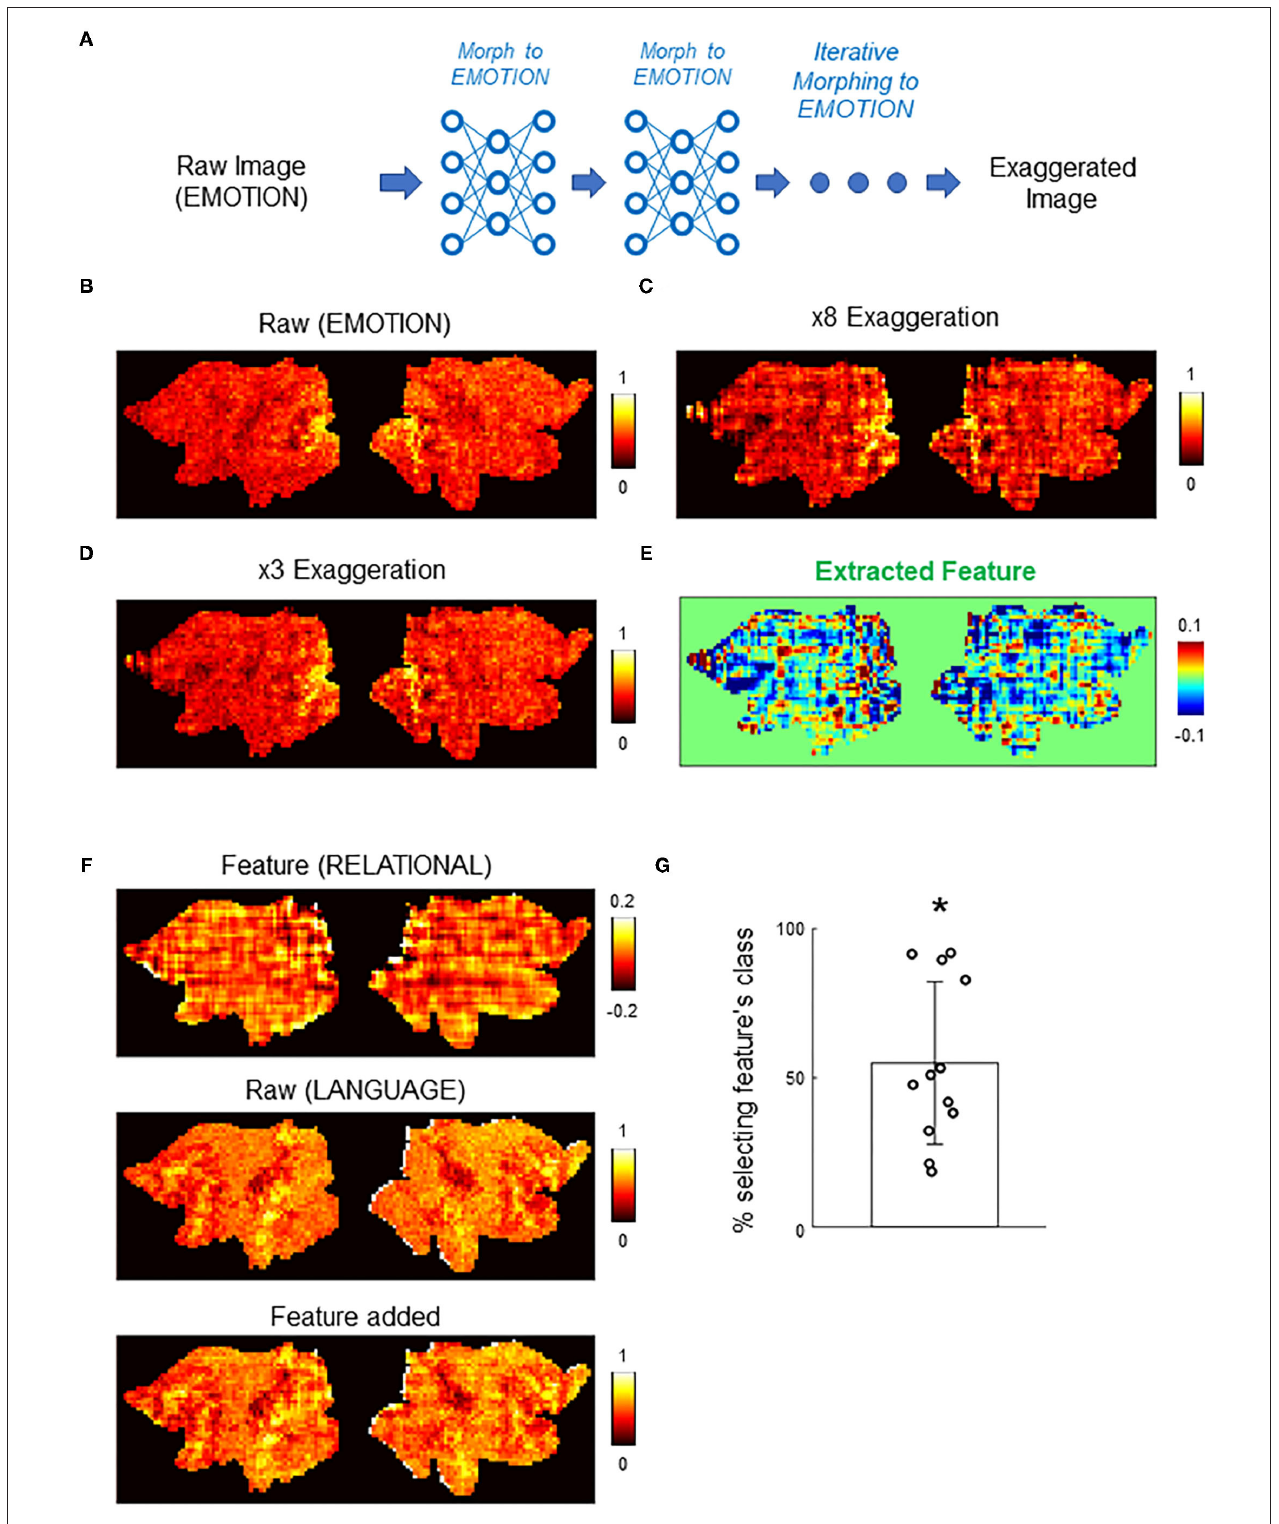
FIGURE 6 | Counterfactual exaggeration of brain activation. (A) Schematic of counterfactual exaggeration. A brain activation (MOTOR task in this example) was iteratively transformed toward MOTOR by CAG. This iterative transformation accentuates (exaggerates) image features that biases the classifier decision toward MOTOR. (B–D) Example of counterfactual exaggeration. A brain activation in the EMOTION task (B) was iteratively transformed toward EMOTION eight times.